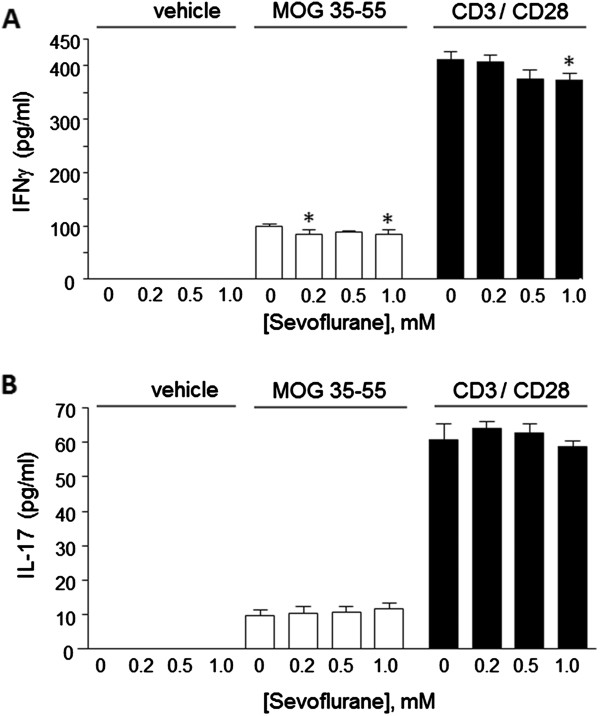
Sevoflurane modifies T cell cytokine production. Splenic T cells were prepared from C57Bl/6 mice 10 days after the booster myelin oligodendrocyte glycoprotein (MOG) immunization, and restimulated ex vivo with vehicle, with MOG35-55 peptide (20 μg/ml), or activated with antibodies to CD3 and CD28 in the presence of the indicated doses of sevoflurane. After 24 h, media levels of (A) interferon (IFN)γ and (B) interleukin (IL)-17 were determined by specific ELISA. Data are mean ± SEM of n = 4 samples per group; *P <0.05 versus 0 sevoflurane (one-way analysis of variance (ANOVA), Tukey post hoc test).